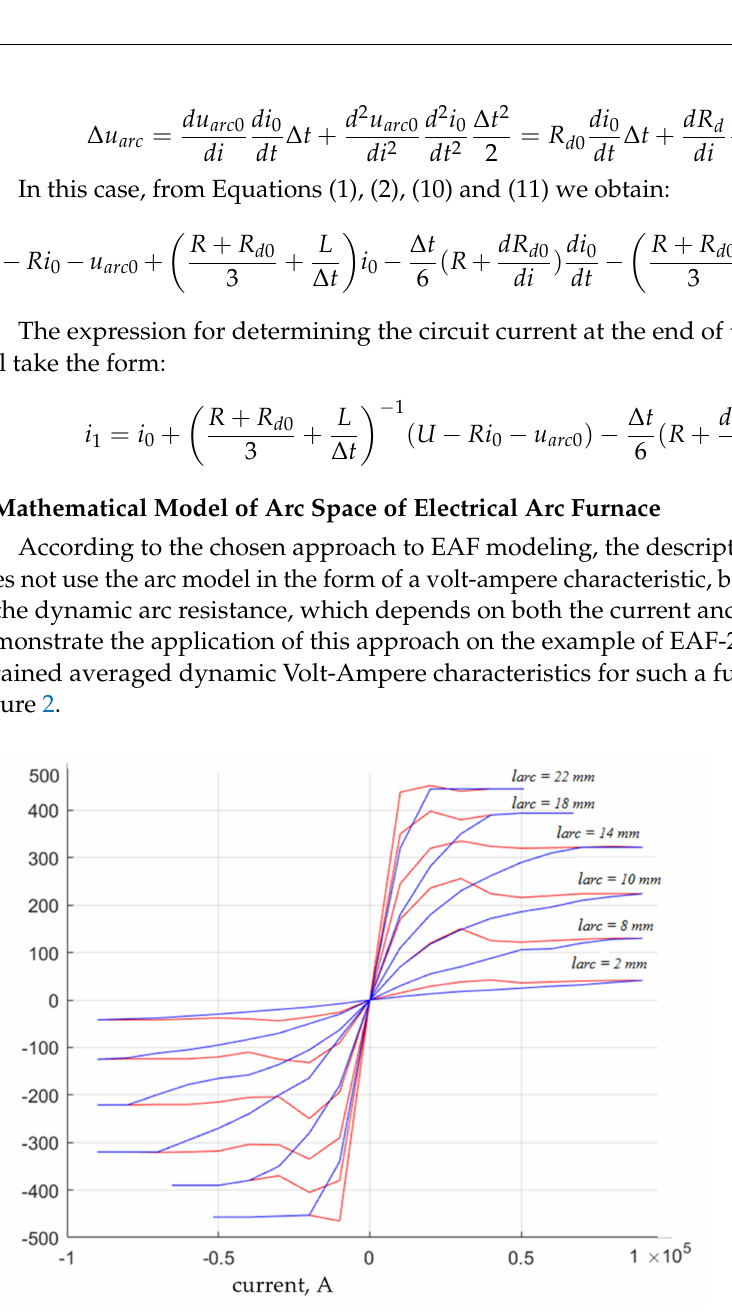
Figure 2. Dynamic Volt-Ampere characteristics of